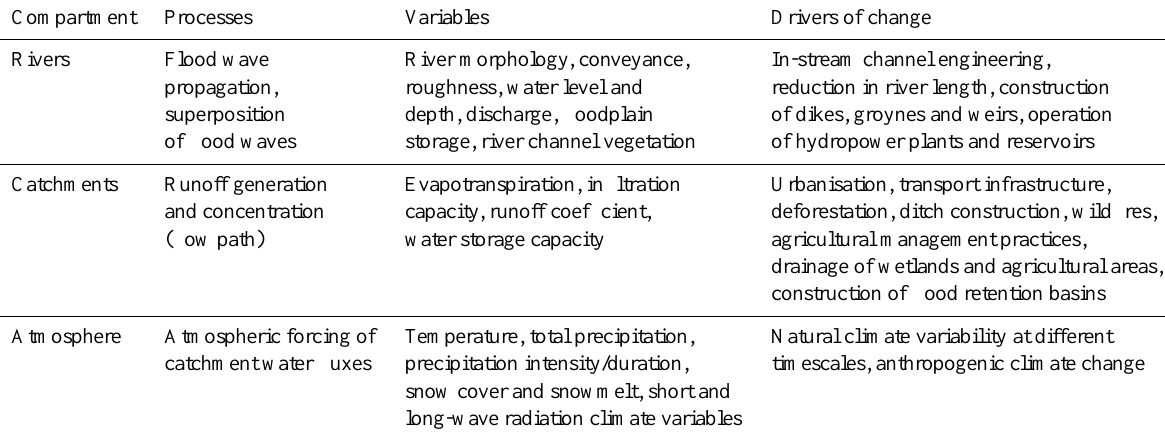
Table 1. Examples of potential drivers of change in flood regimes and associated variables (modified from Merz et al.,